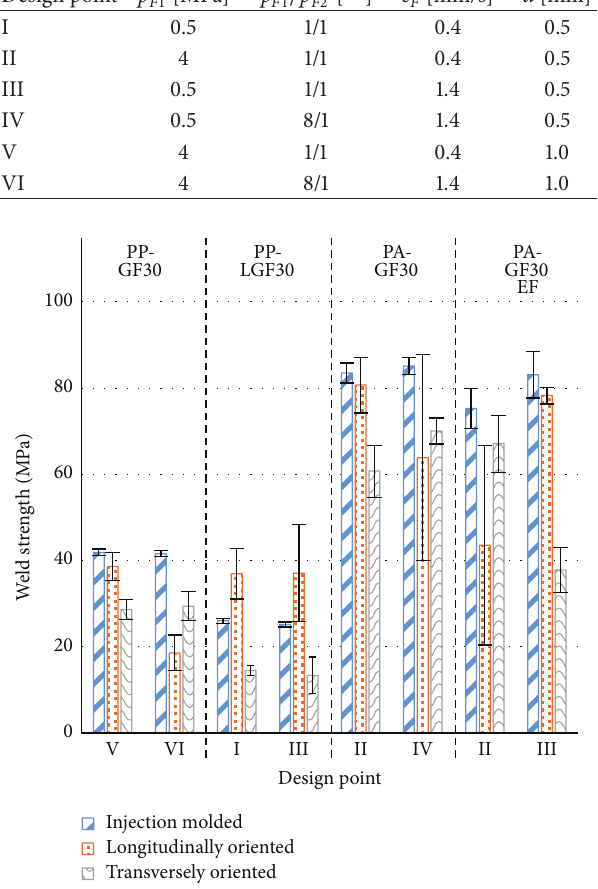
Figure 15: Weld strength in hot plate welding for different initial fiber orientations.